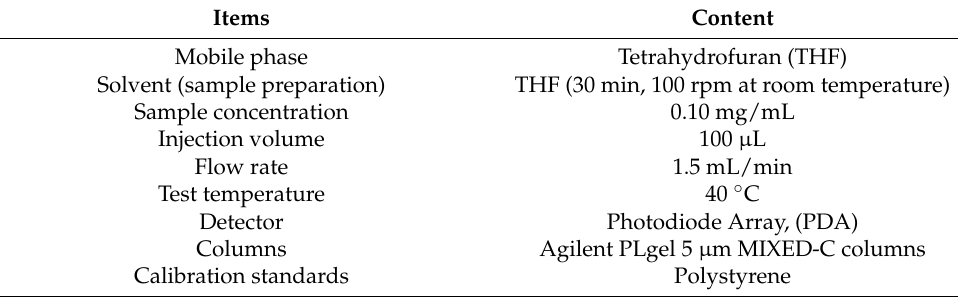
Table 2. GPC test conditions for bitumen.